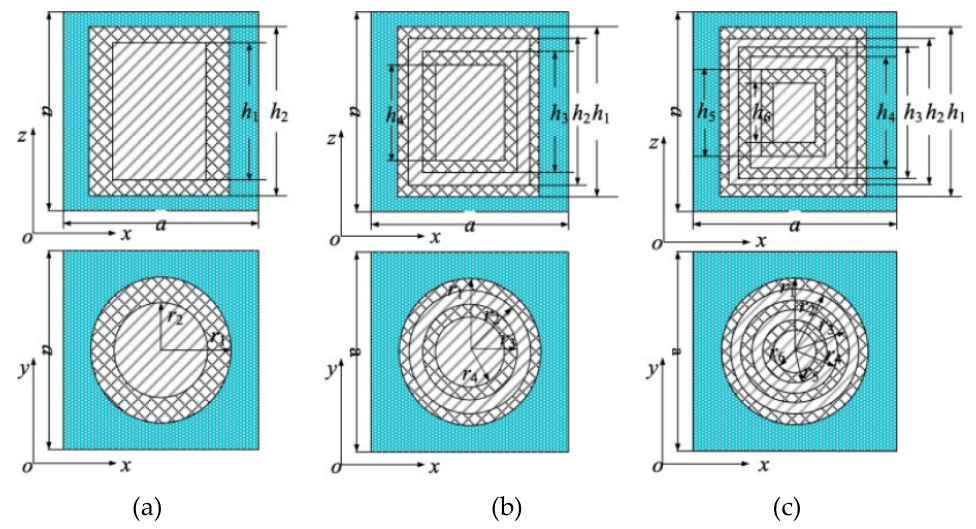
Figure 34. The cross-section for a unit cell of the three proposed devices: ( a ) Conventional LRAMs; ( b ) LRAMs with double-layered cylindrical scatterers; ( c ) LRAMs with three-layered cylindrical scatterers [101].